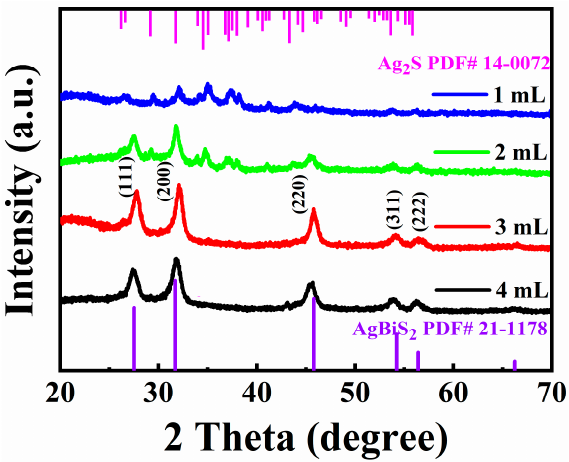
Figure 5. XRD patterns of colloidal OLA–S–based AgBiS 2 NCs using 1 mL, 2 mL, 3 mL, and 4 mL.